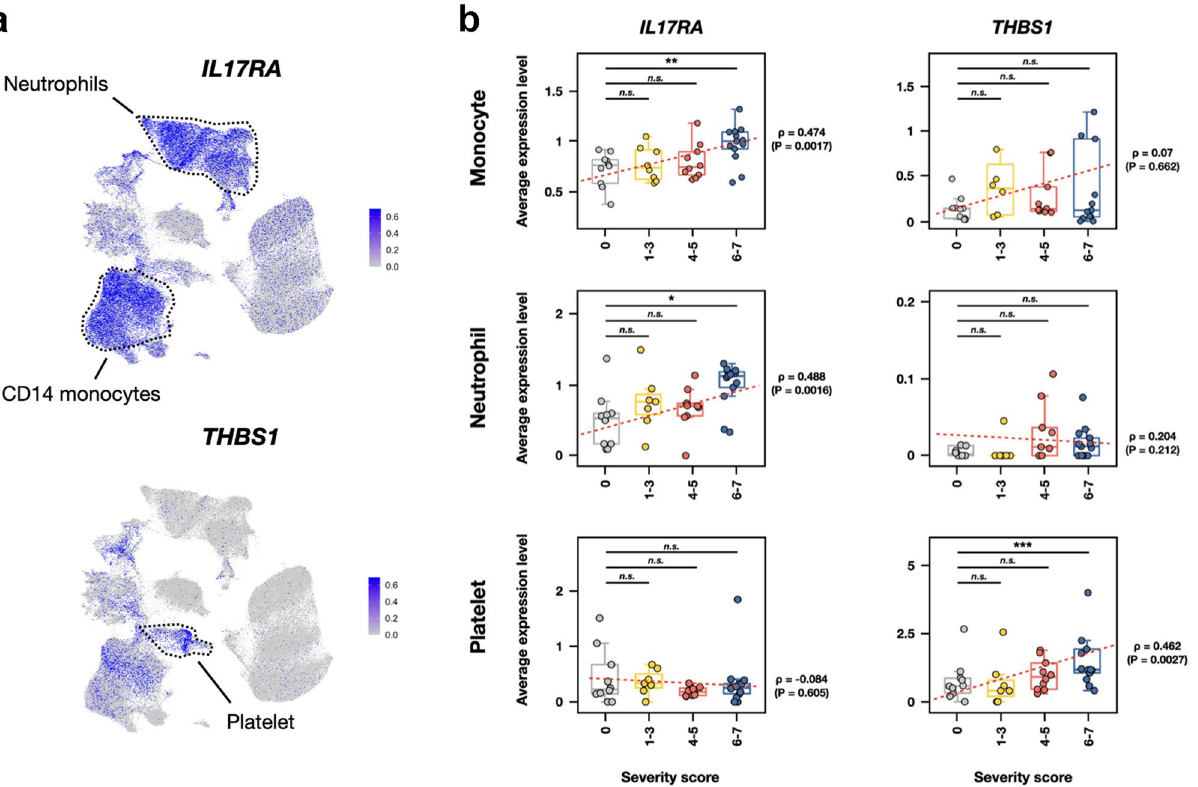
Figure 2. In severe and fatal COVID-19 patients, IL17RA expression is elevated in monocytes and neutrophils, but THBS1 expression is elevated in platelets. ( a ) Two-dimensional UMAP projections of single cells from the GSE174072 cohort scRNA-Seq data colored by expression levels of IL17RA and THBS1 . ( b ) Box plots depicting average expression levels of IL17RA and THBS1 in monocyte (top), neutrophil (middle), and platelet (bottom). Patients are grouped by the severity score at the time of sample collection. * P < 0.05; ** P < 0.01; *** P < 0.001; n.s not significant at P = 0.05 by two-sided Wilcoxon rank-sum